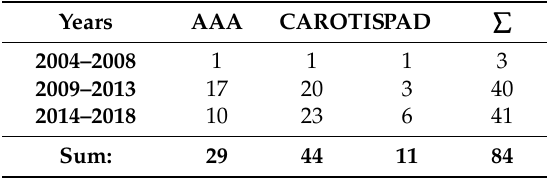
Table 2. List of publications resulting from our Munich Vascular